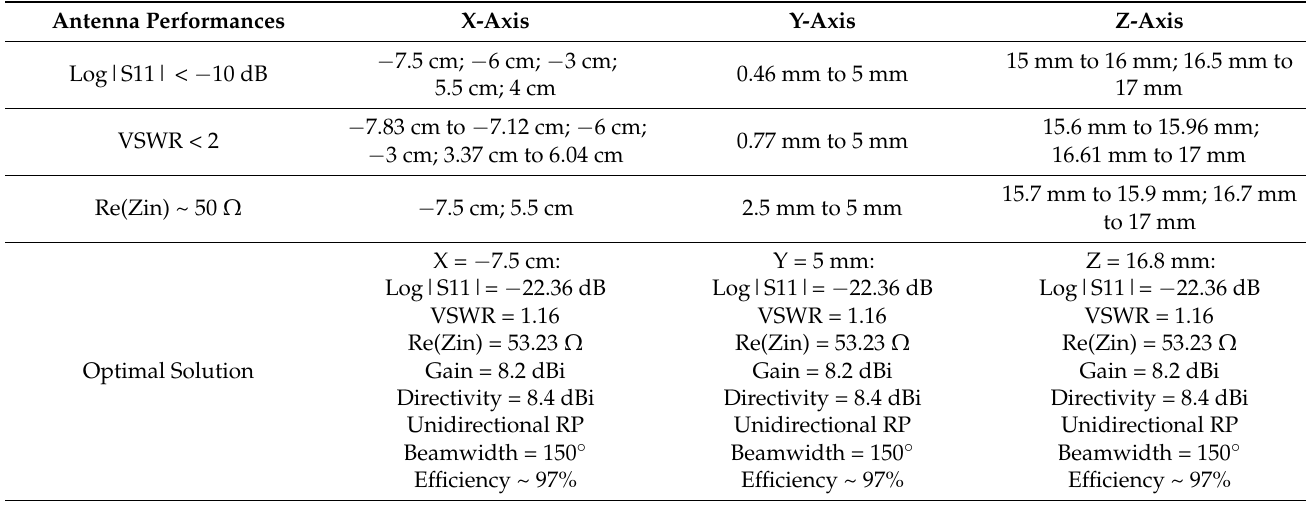
Table 5. Performances of proposed full satellite at 2450 MHz along X-, Y-, and Z-axis. Antenna